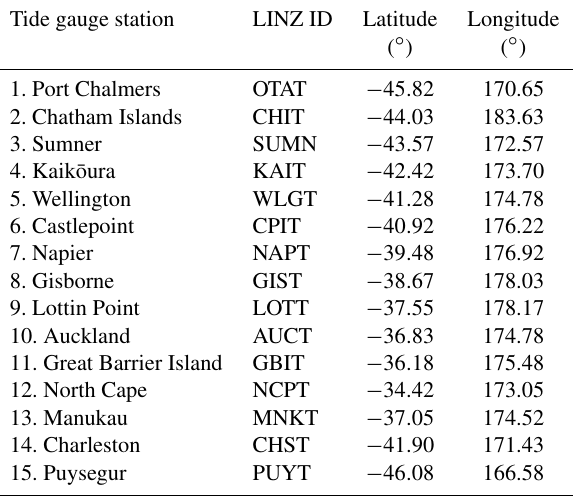
Table 2. Land Information New Zealand (LINZ) tide gauge station names, ID and locations for model–data evaluation of sea level. Tide gauge